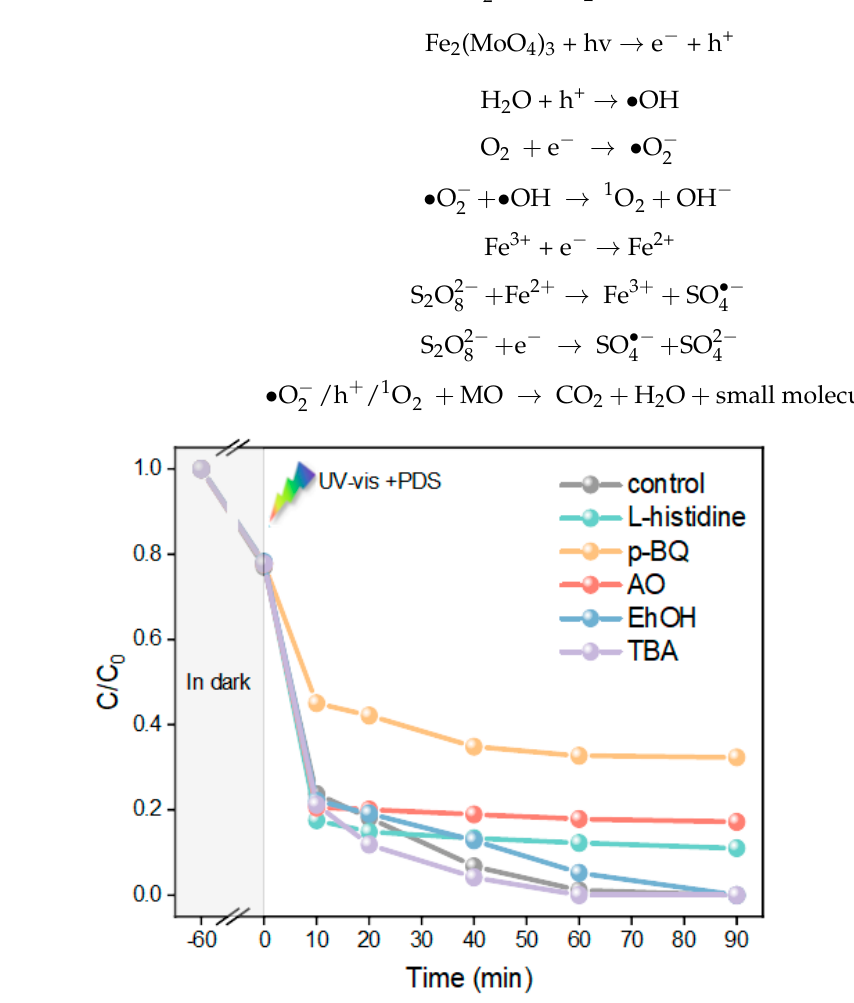
Figure 6. Reactive oxygen species trapping experiments.